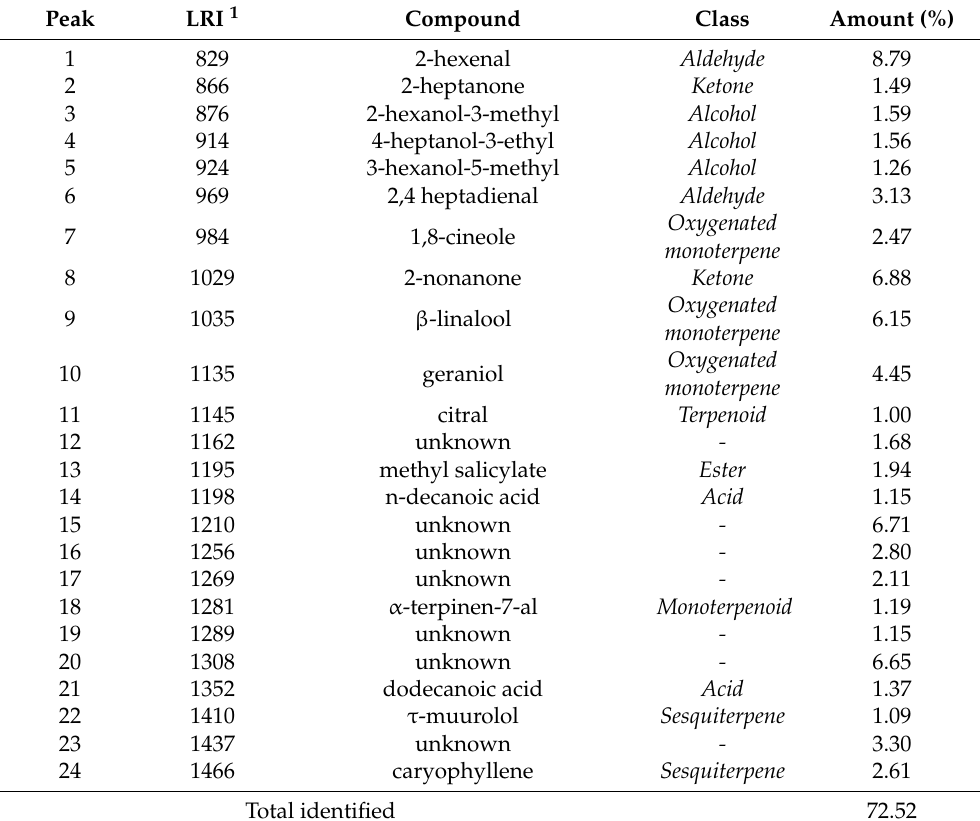
Table 2. Volatile fraction composition of raspberry leaves hydrolate hexanoic extract determined by GC/MS. 1 LRI: Linear Retention